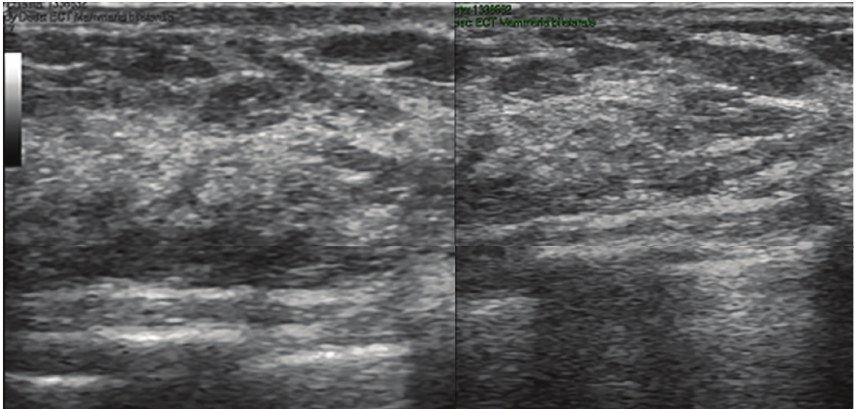
Figure 2: US does not show significant alterations in the subareolar region of the left